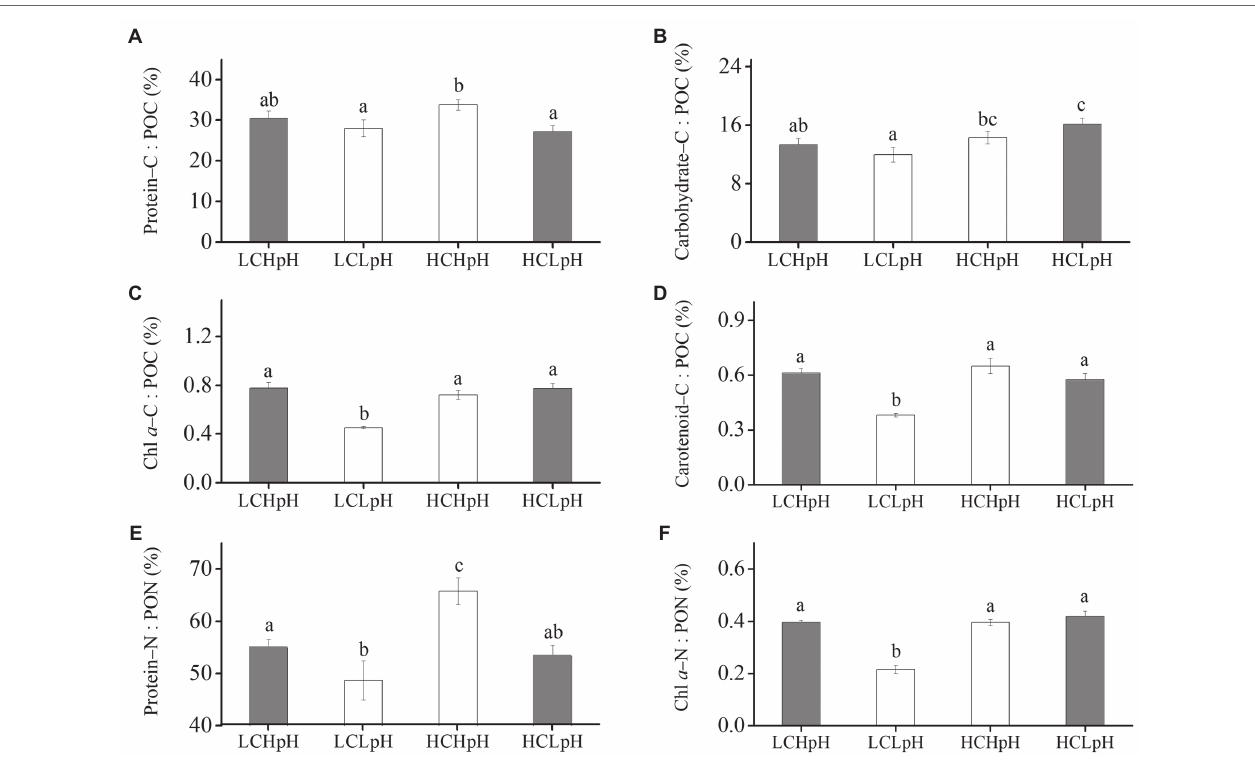
FIGURE 5 | Percentage of POC allocated to (A) protein, (B) carbohydrate, (C) Chl a and (D) carotenoid, percentage of PON allocated to (E) protein and (F) Chl a of E. huxleyi RCC1266 under the LCHpH (gray), LCLpH, HCHpH, and HCLpH (gray) treatments. Different letters (a, b, c) in each panel represent significant differences between four treatments (Tukey Post hoc , p < 0.05). For more information, please see Figure 1